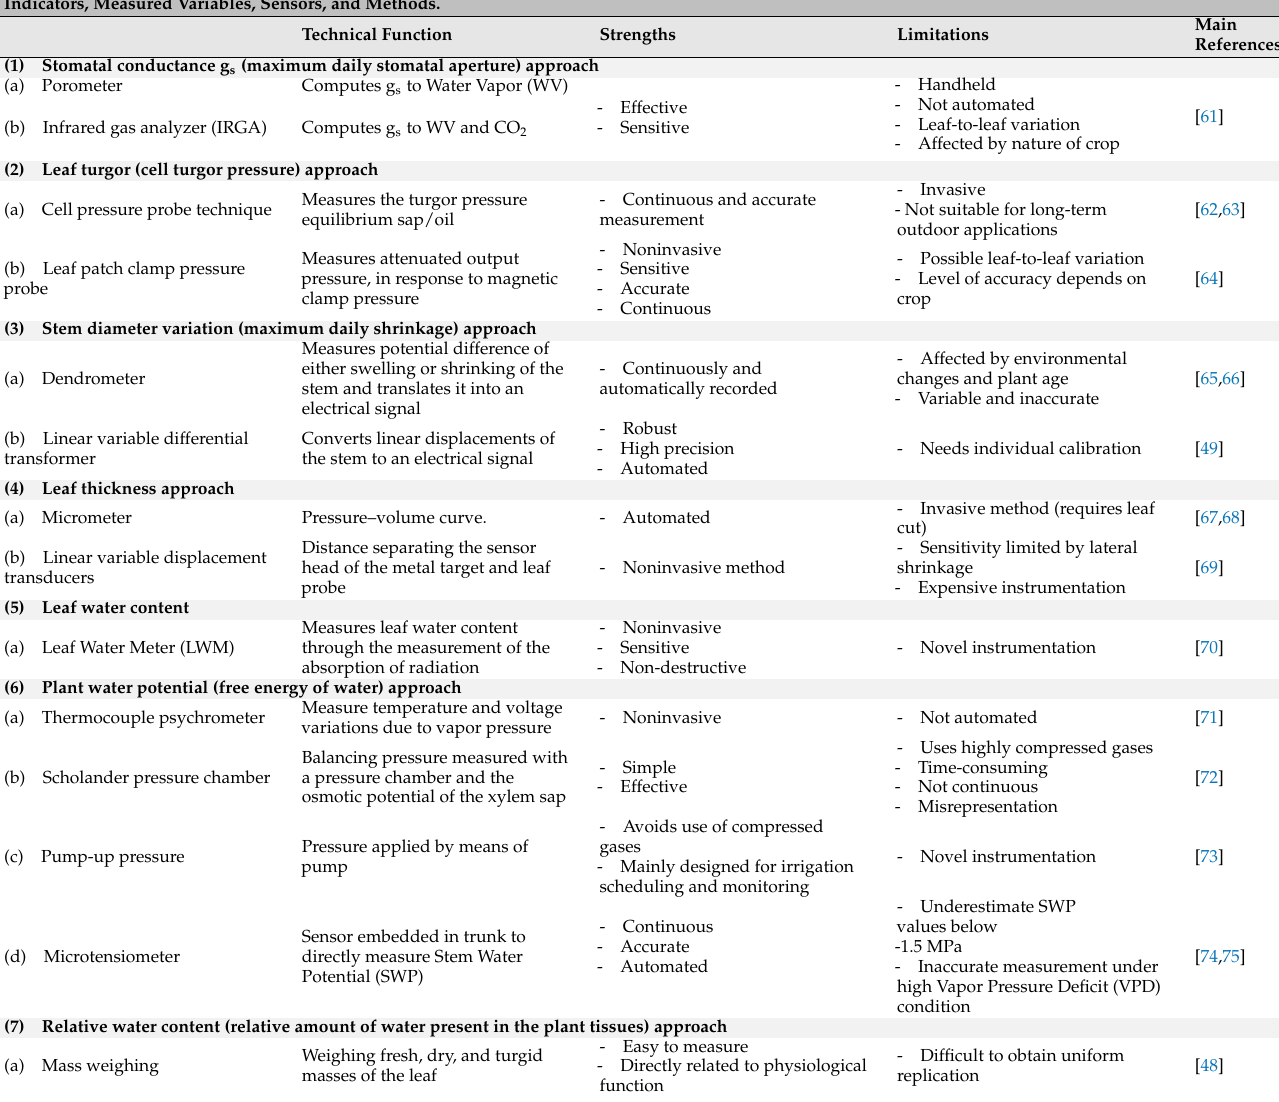
Table 1. A summary of the main plant-based water stress indicators, measured variables, respective sensors and methods with their technical functions, and their main strengths and limitations for better irrigation